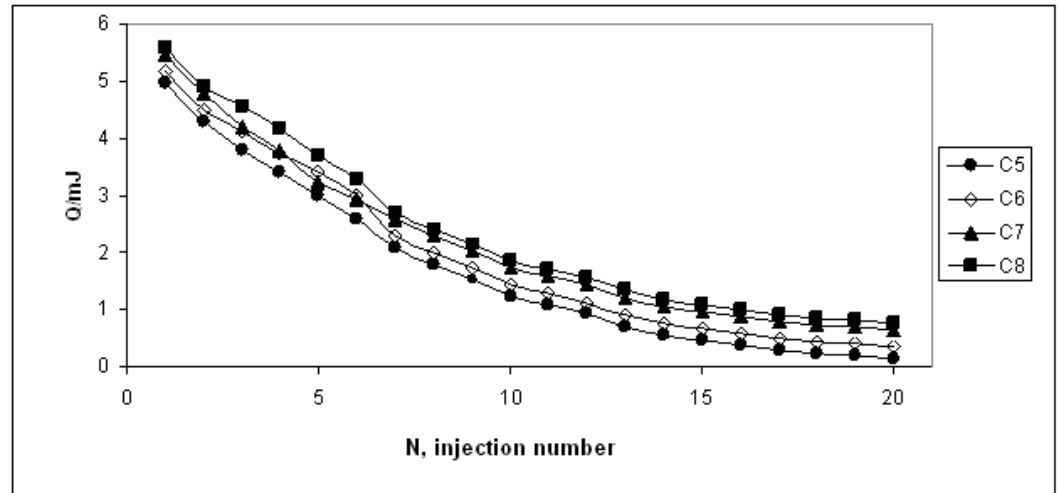
Figure 2. Heat evolution per injection, Q, plotted against injection number, N. The fitted lines are: ● pentan-1-ol, ◊ hexan-1-ol, ▲ heptan-1-ol, ■ octan-1-ol. ————, fitted